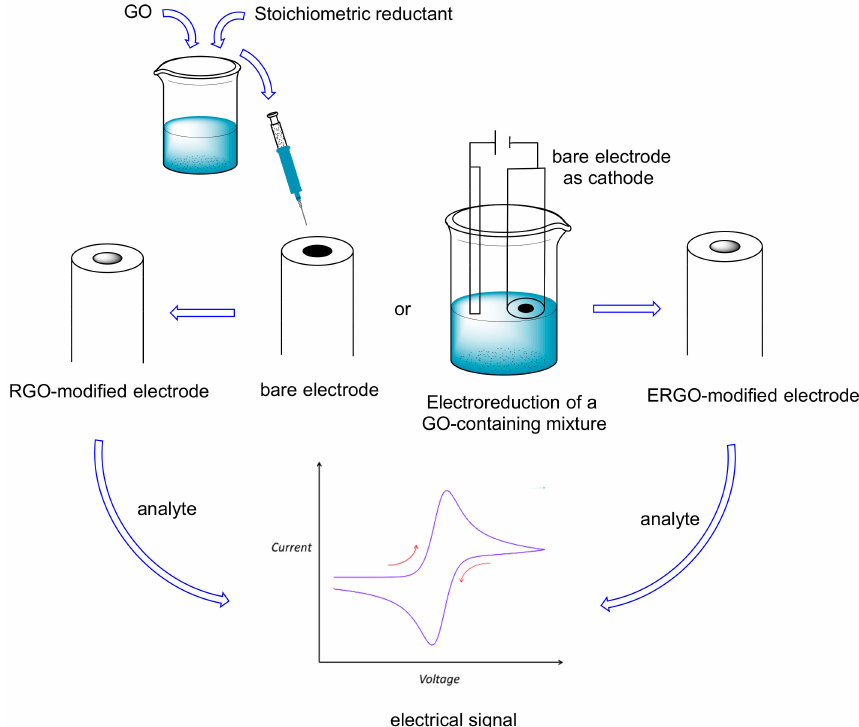
Figure 5. RGO or ERGO use for methylxanthines electrochemical